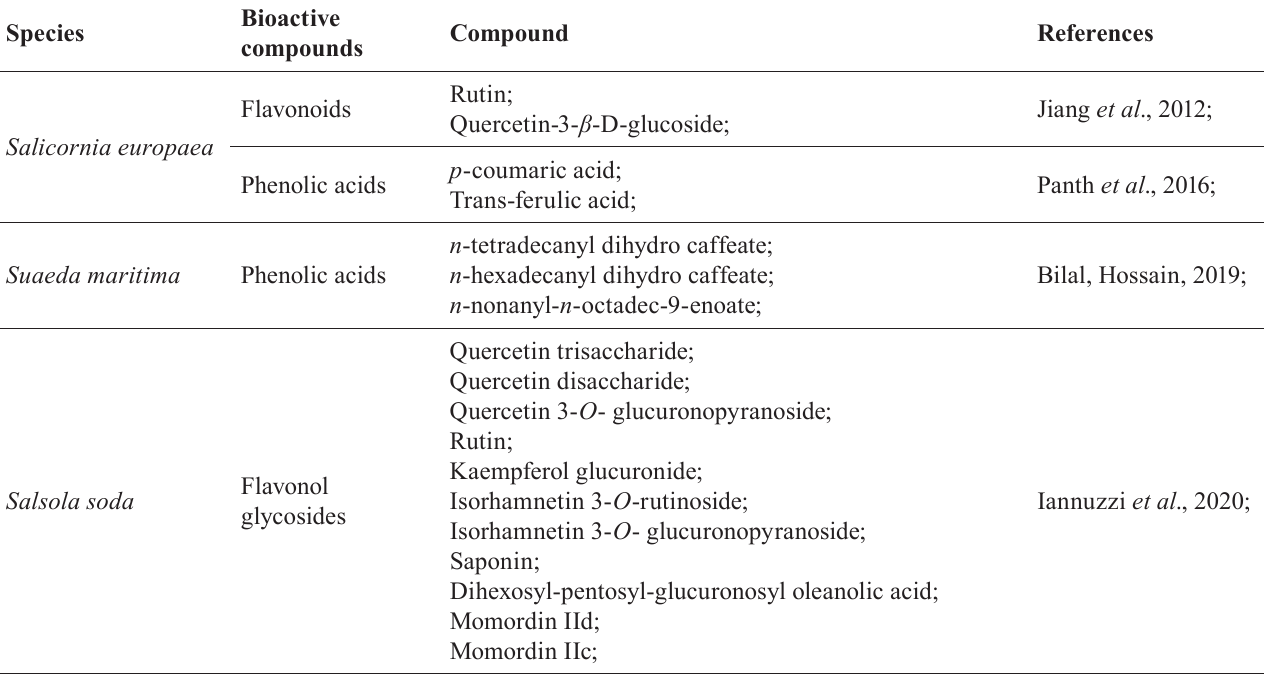
TABLE I - S econdary metabolites of presented halophytic Amaranthaceae species